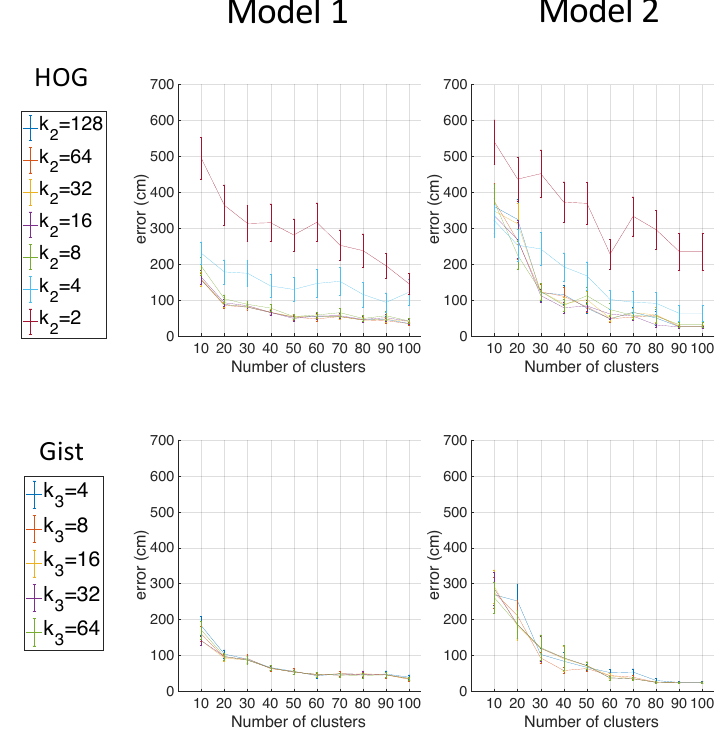
Figure 20. Results of the localization process in the Freiburg environment by using two types of models to retain visual representatives. Average localization error (cm) vs. number of clusters. Model 1 uses representatives obtained through spectral clustering, and Model 2 obtains the representatives through sampling the dataset. The localization task has been carried out with HOG and gist , and the distances are calculated through the cosine